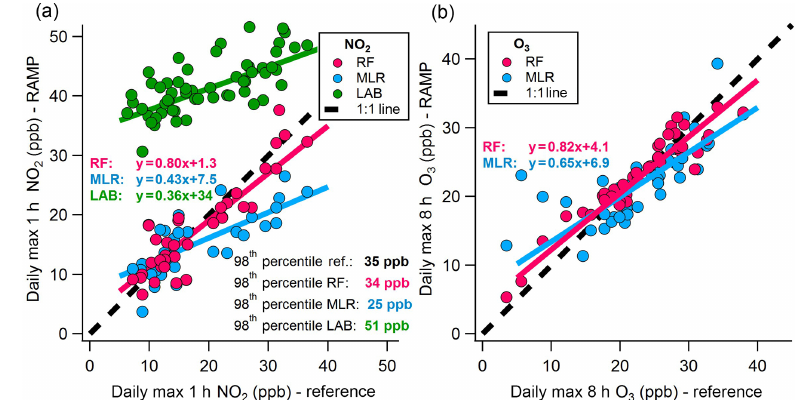
Figure 13. Performance of one representative RAMP monitor (RAMP #1) for NAAQS compliance metrics (O 3 : daily max 8h; NO 2 : 98th percentile of daily max 1h averages). (b) Comparison of daily 8h maximum reference monitor ozone concentrations ( x axis) to MLR and RF models. (a) Comparison of daily 1h maximum reference monitor concentrations versus the LAB, MLR, and RF models. The NO 2 standard is the 98th percentile of the daily 1h